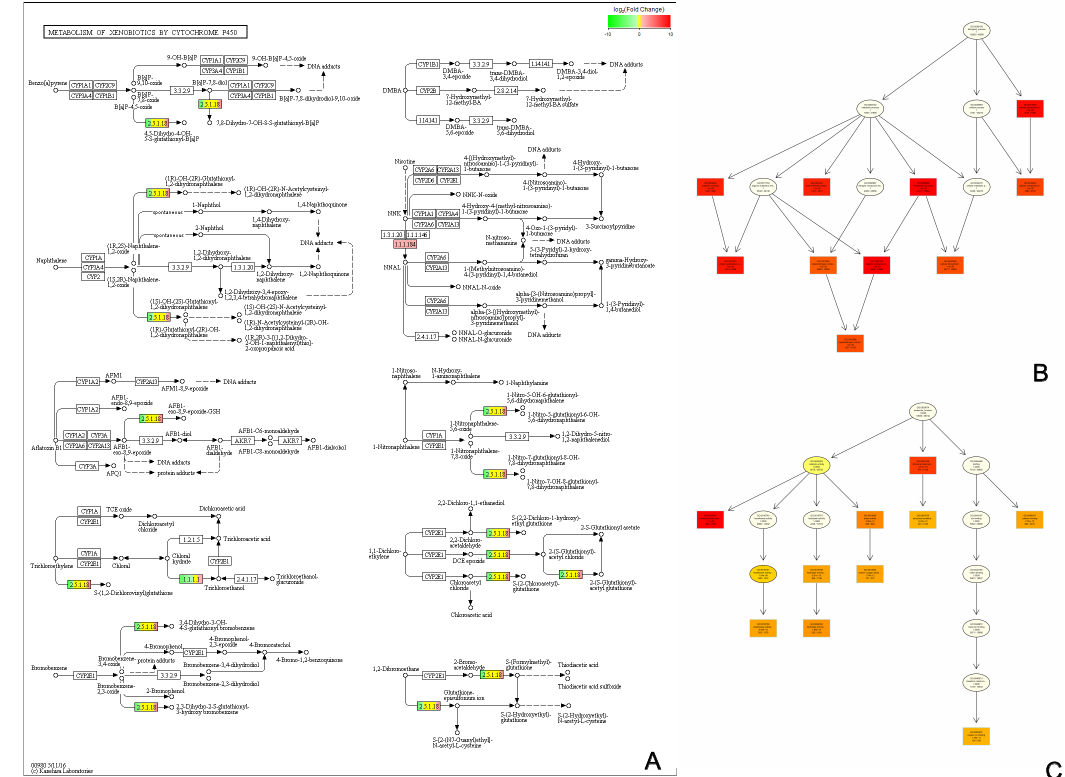
Figure 1. Three study regions in California. Figure 5. Pathway and functional analysis of the P450 gene. ( A ) The pathway map for the metabolism of xenobiotics by cytochrome P450 was obtained from the statistical analysis of DEG metabolic pathways from KEGG database comparison; ( B , C ) the Directed Acyclic Graph (DAG) of the biological process and molecular function for P450-related di ff erential genes was obtained by GO enrichment analysis using topGO. The depth of the color represents the degree of enrichment, with a darker color representing a higher degree of